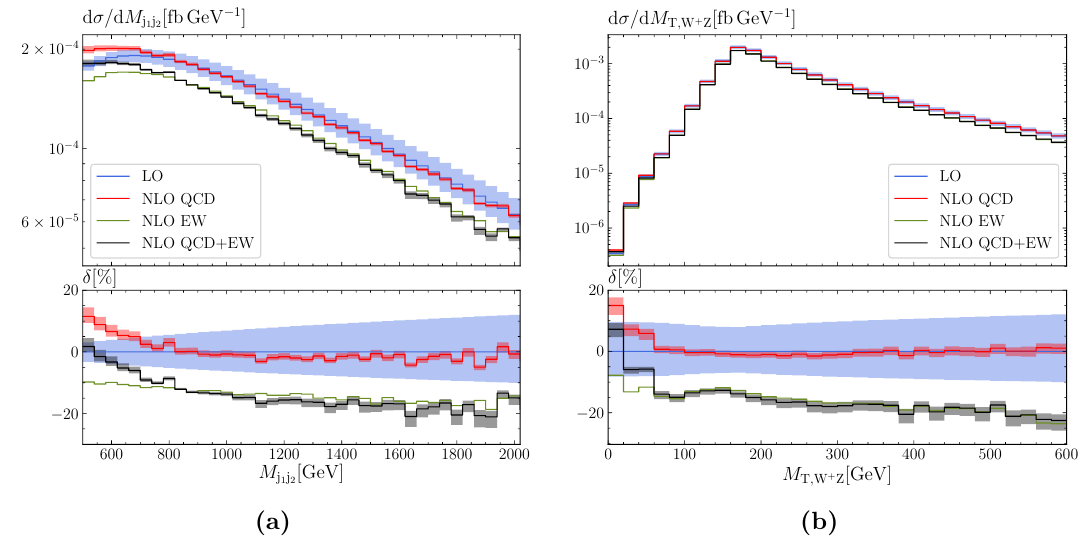
Figure 10. Di(cid:11)erential distributions for pp (cid:22) + (cid:22) (cid:0) e + (cid:23) e jj + X at the LHC with CM energy ! 13 TeV: (a) invariant mass of the two tagging jets (left), and (b) transverse mass of the four lepton system (right). The upper panel shows the LO contributions of order (cid:11) 6 , the two NLO O predictions [including (NLO QCD)] as well as their sum. The (cid:0) O lower panel shows the relative NLO corrections with respect to the LO in (cid:1)